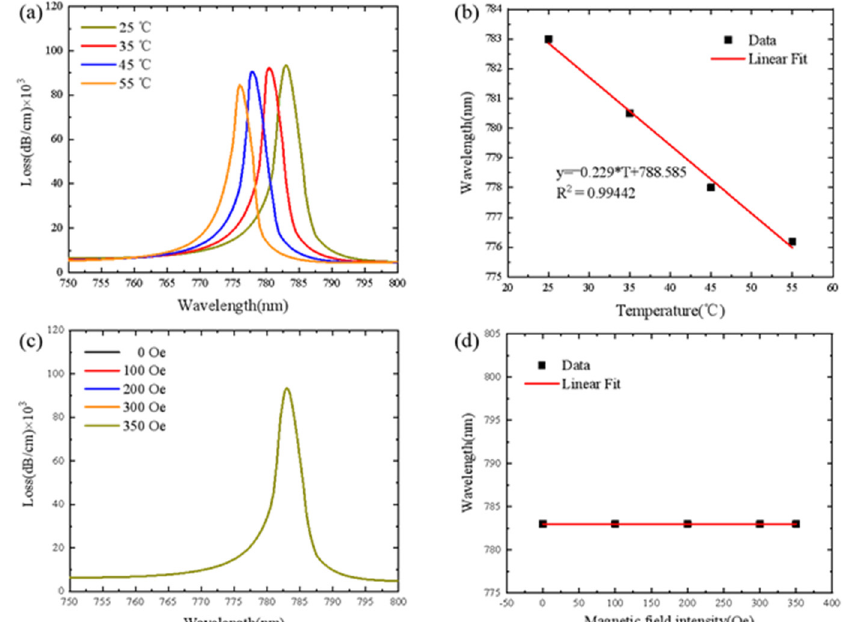
Figure 4. ( a ) Loss spectra of Channel 1 under different temperatures (magnetic field is fixed as 0 Oe). ( b ) Fitting results of resonance wavelength at different temperatures. ( c ) Loss spectra of Channel 1 under different magnetic field strength (temperature is fixed as 25 ◦ C). ( d ) Fitting results of resonance wavelength at different magnetic field strength.